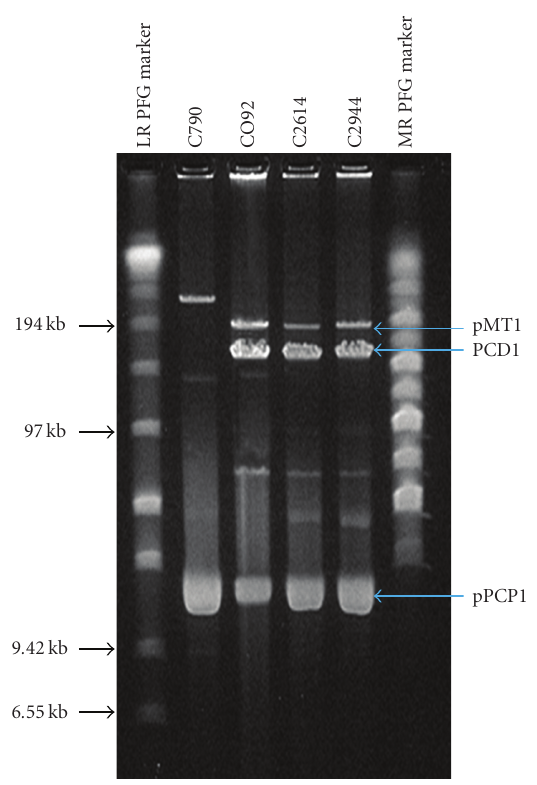
Figure 2: Pulsed field gel electrophoresis of total plasmid content on 1% agarose gel. Lane 1: low range PFG marker, lane 2: C790, lane 3: CO92, lane 4: C2614, lane 5: C2944 and lane 6: medium range PFG marker.